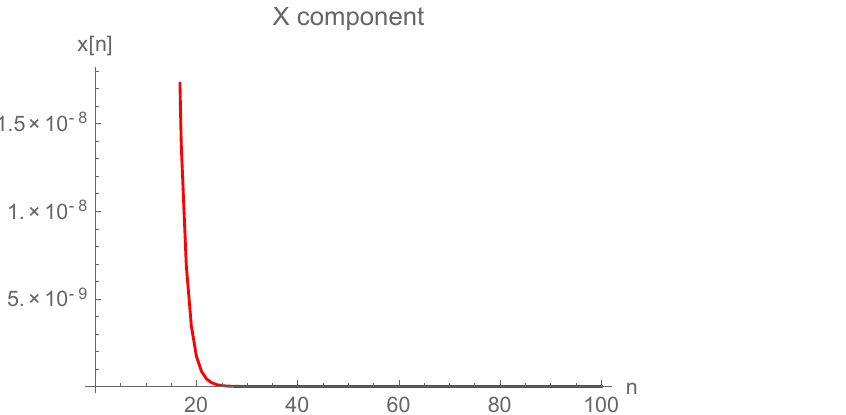
Figure 14. Graph of attractors x n y n (shown in blue line) y n z n ,(shown in green line) z n y n (shown in red line) in 2D for α = 2.5, β = 0.05, γ = 0.7, δ = 0.6, ζ = 3.5, η = 0.05, µ = 0.01, ε = 4.1, υ = 0.09, ρ = 0.02, σ = 0.04, ω = 0.06. with initial conditions x 0 = 0.1, y 0 = 0.02 and z 0 = 0.04.